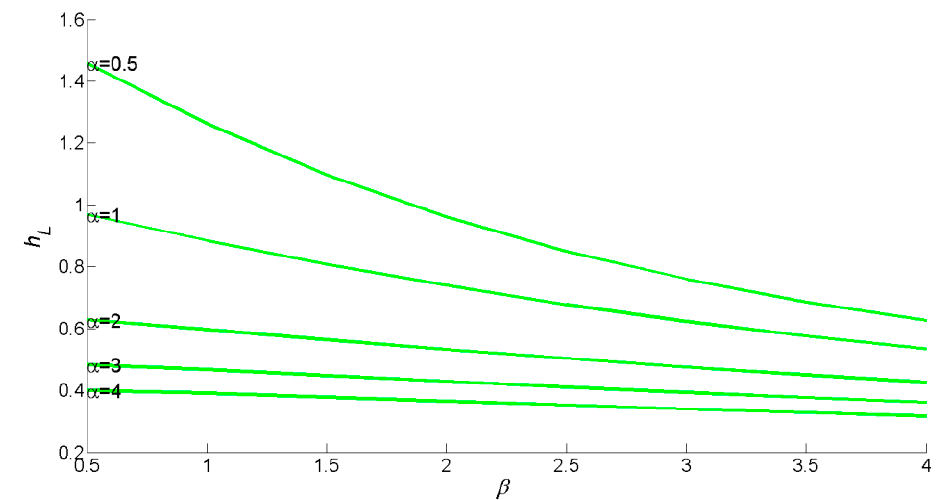
Figure 5. Trend of the maximum routing elevation (h L ) as a function of the spillway DC α and the SC β .